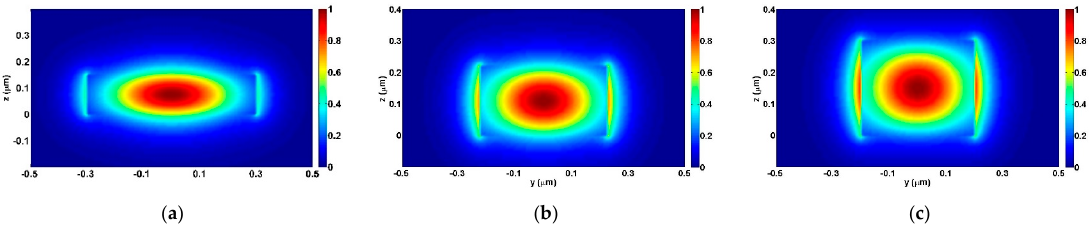
Figure 2. Electric field intensity distribution over the cross section of a waveguide with ( a ) 𝐻 = 150 nm and 𝑊 = 600 nm , ( b ) 𝐻 = 220 nm and 𝑊 = 450 nm , and ( c ) 𝐻 = 300 nm and 𝑊 = 400 nm . The buried oxide layer lies below 𝑧 = 0 .